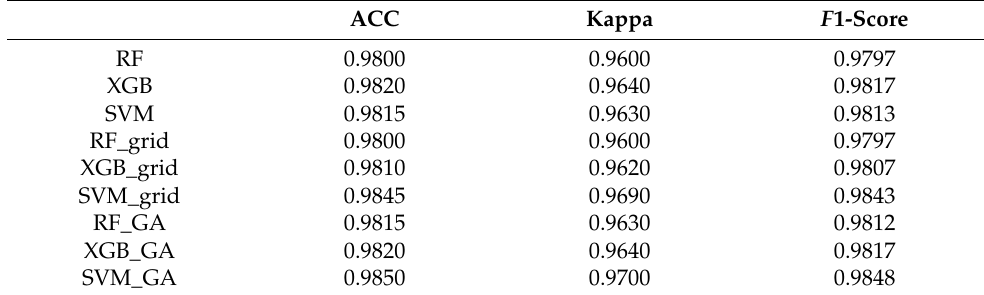
Table 5. Performance of ML models with default and optimized hyper-parameters using a genetic algorithm and grid search method on the transfer